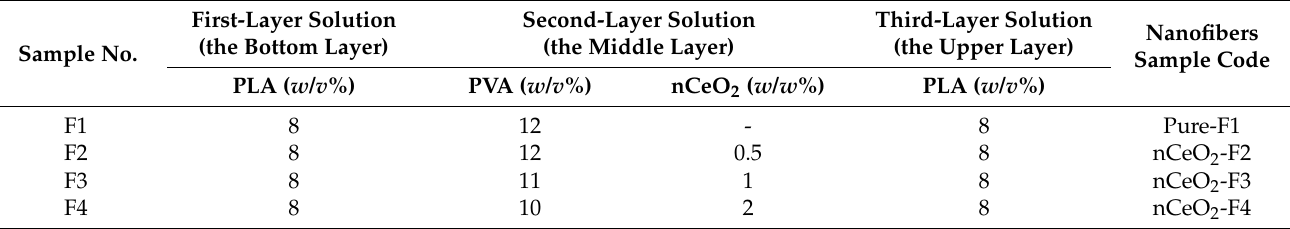
Table 1. Composition of the synthesized nCeO 2 -incorporating